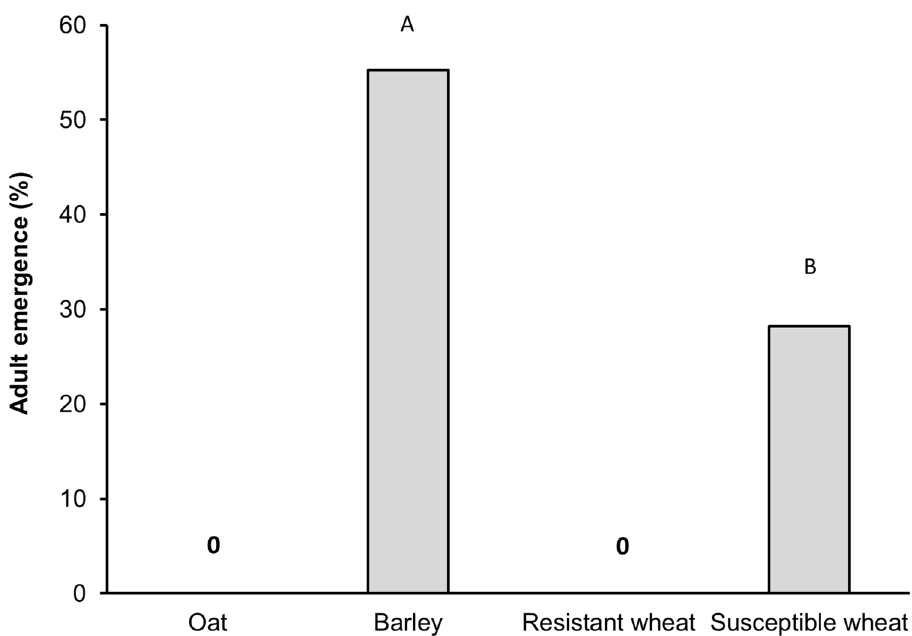
Figure 4. Percentage of adult emergence on each host plant treatment in no-choice test. Oat (cv. Cayuse); Barley (cv. Champion); Resistant wheat (cv. Hollis); Susceptible wheat (cv.